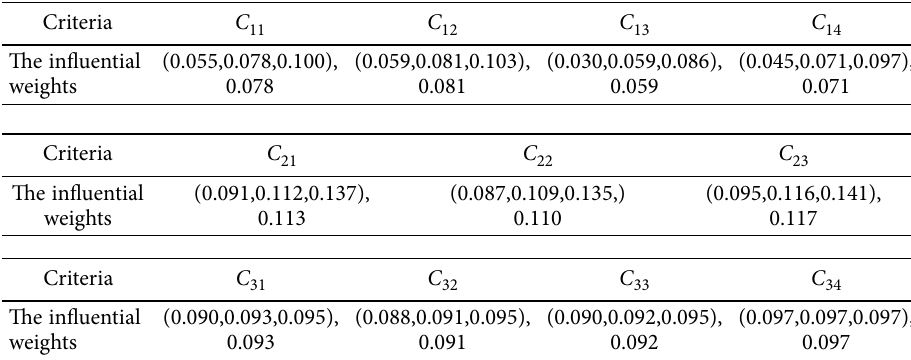
Table 5. The fuzzy/de-fuzzy influential weights obtained from the steady-state